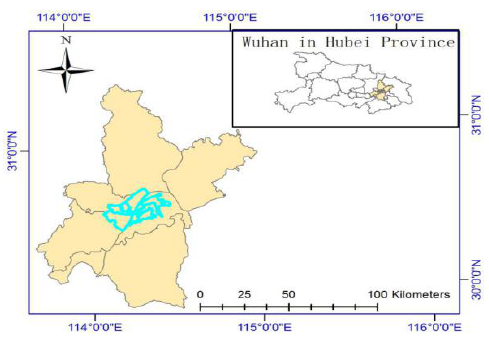
Fig. 1 Selection of urban area in